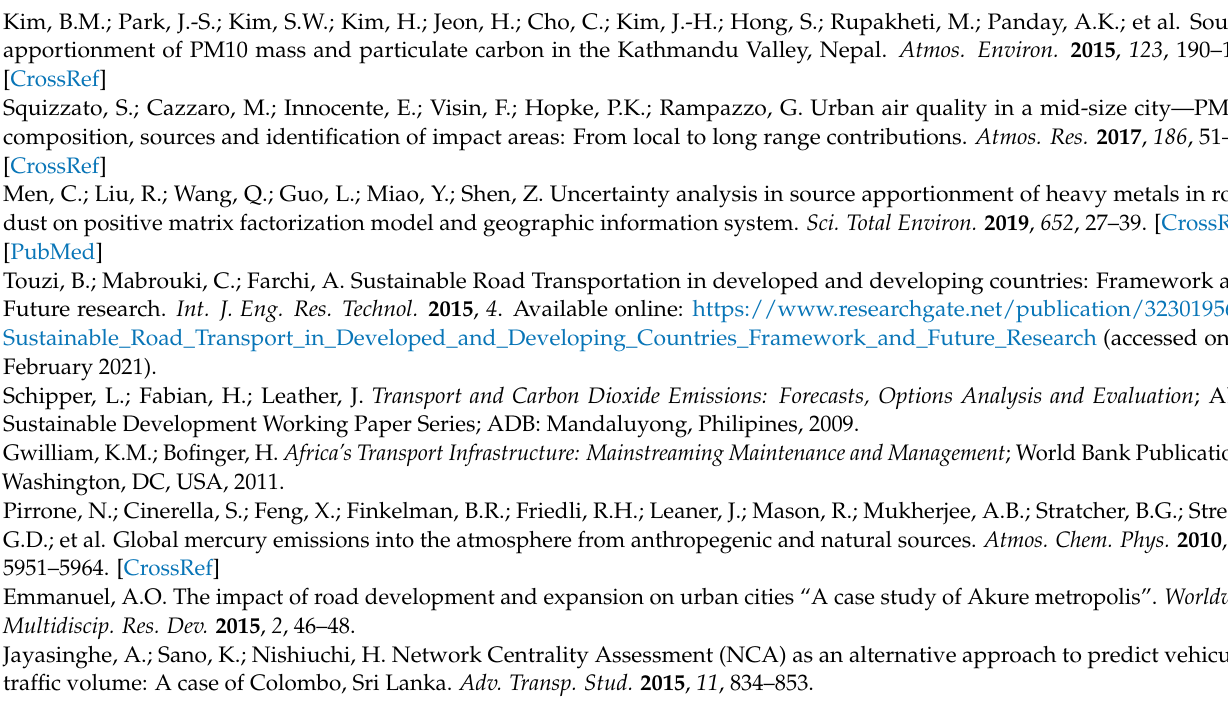
Figure A3. Map of Nigeria highlighting Kano State and satellite image of Nassarawa Local Govern- ment Areas showing typical week day traffic (Source: Google maps ®